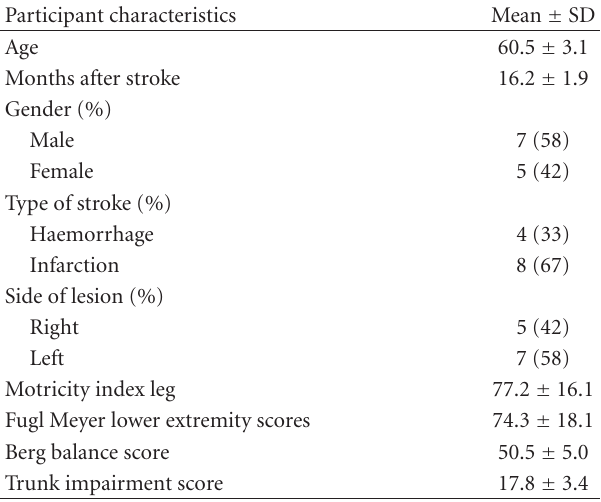
Table 2: Characteristics of the twelve participants. The means and standard deviations are given, as well as the frequencies and percentages (between brackets). Maximum scores are 100 for motricity index, 100% for Fugl Meyer lower extremity, 56 for berg balance score and 23 for trunk impairment scale.